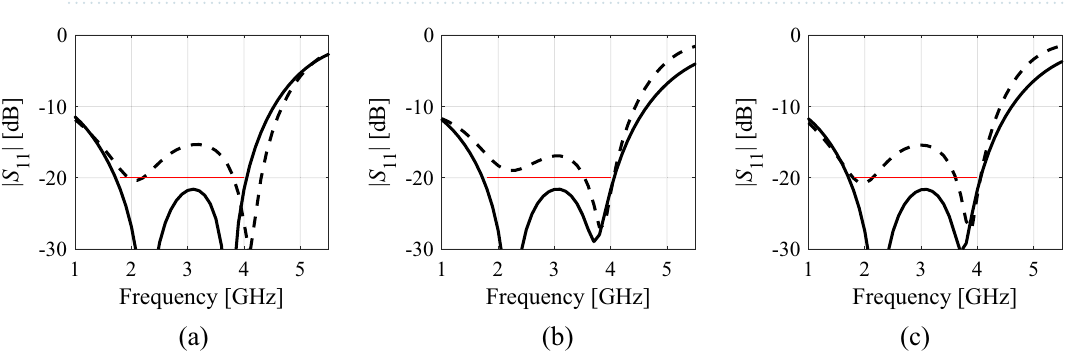
Figure 9. Structure II responses obtained in selected runs of the proposed algorithm: ( a ) run 1, ( b ) run 2, ( c ) run 3: design found after the global search stage (gray), final design (black). The vertical line marks the target operating frequency of 1 GHz.